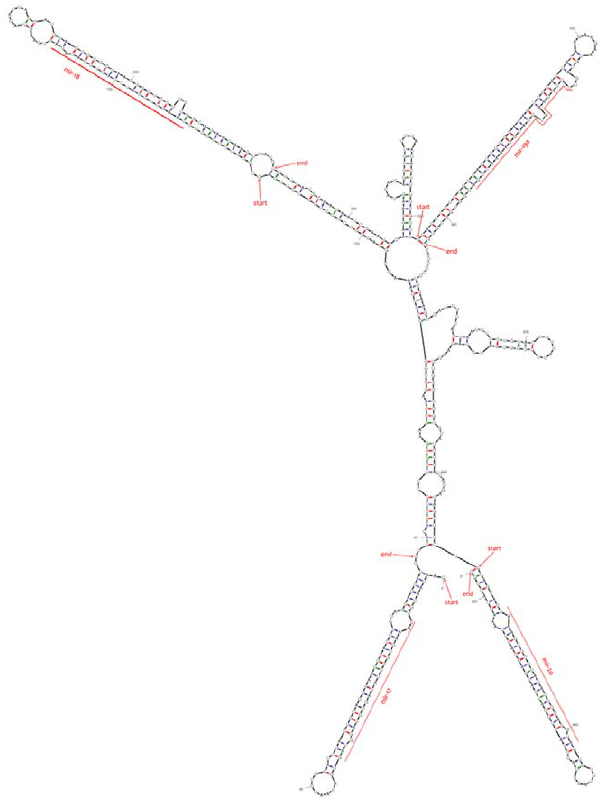
Figure 4. The folding secondary structure of porcine mir-17- mir-20 cluster predicted computationally by RNAfold. Folding secondary structure of porcine mir-17 cluster including four miRNAs (mir-17, mir-18, mir-19a and mir-20) and flanking sequences was predicted by RNAfold. The sequences from start to end represent pre-